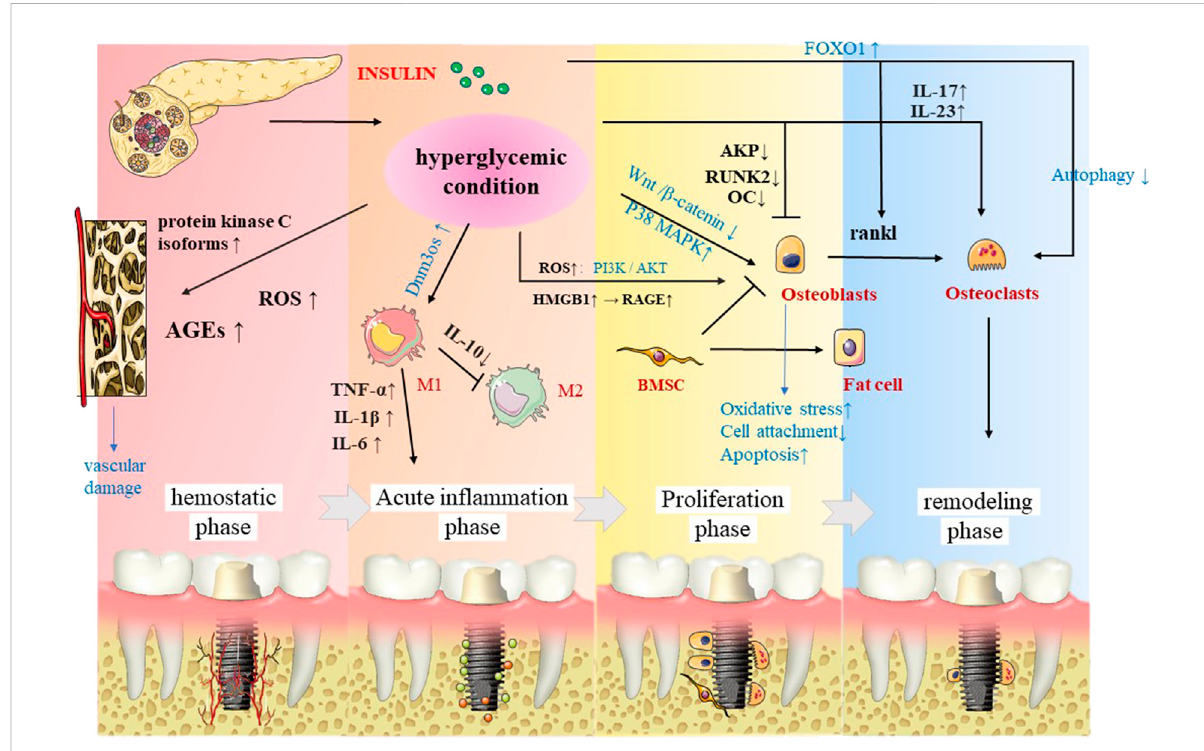
FIGURE 2 In the four stages of osseointegration, insulin signi fi cantly affects the implants not only directly by osteoblasts and osteoclasts, but also affects the implants through macrophage polarization, as well as